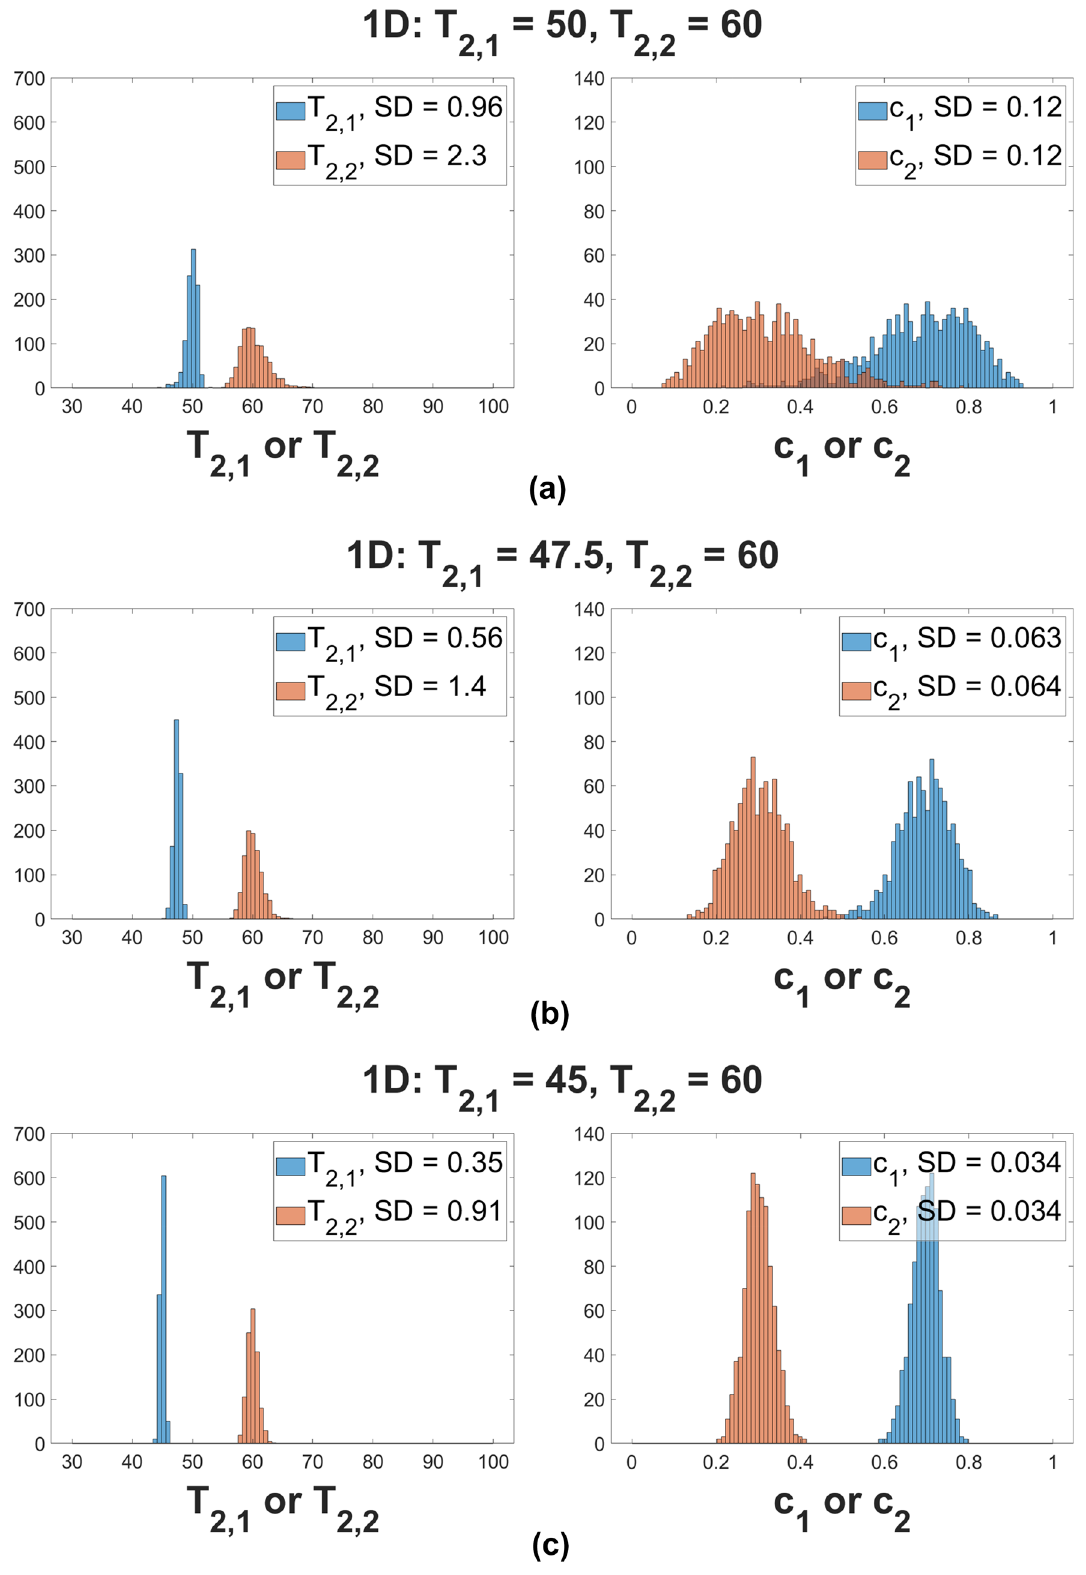
Figure 3. Histograms of one-dimensional MC simulation results for parameter recovery from the 1D biexponential model Eq. 2. All rows share the same underlying values ( c 1 , c 2 ) are as indicated. The standard deviations, denoted SD, are calculated from the distributions obtained with MC simulations. For all MC simulations, the smaller value of the derived time constants is assigned to T 2,1 and the larger to T 2,2 , with their fractions c 1 and c 2 assigned